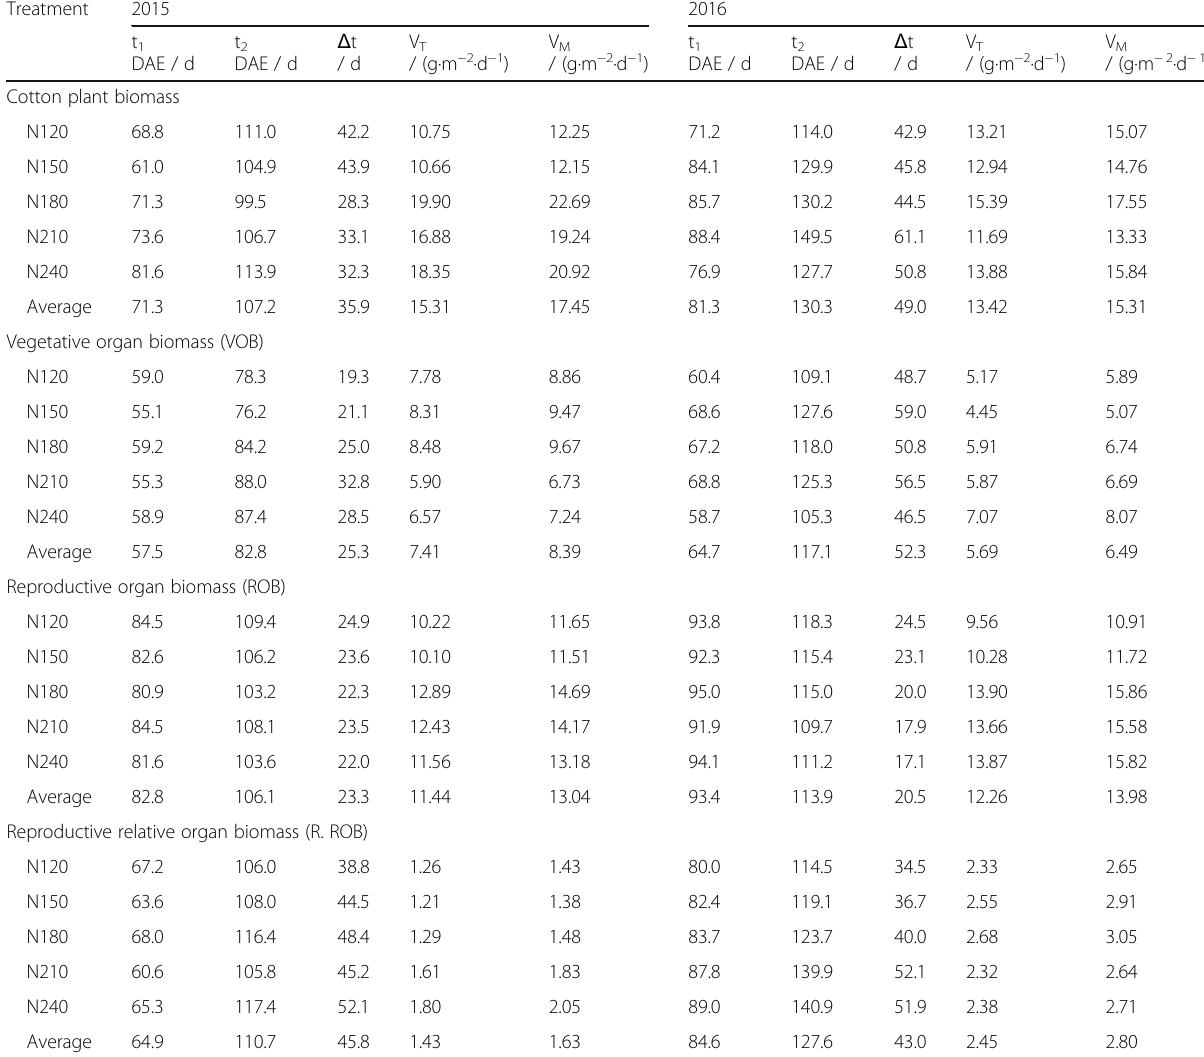
Table 4 Eigenvalues of cotton plant biomass accumulation in the field were affected by different N rates in 2015 and 2016